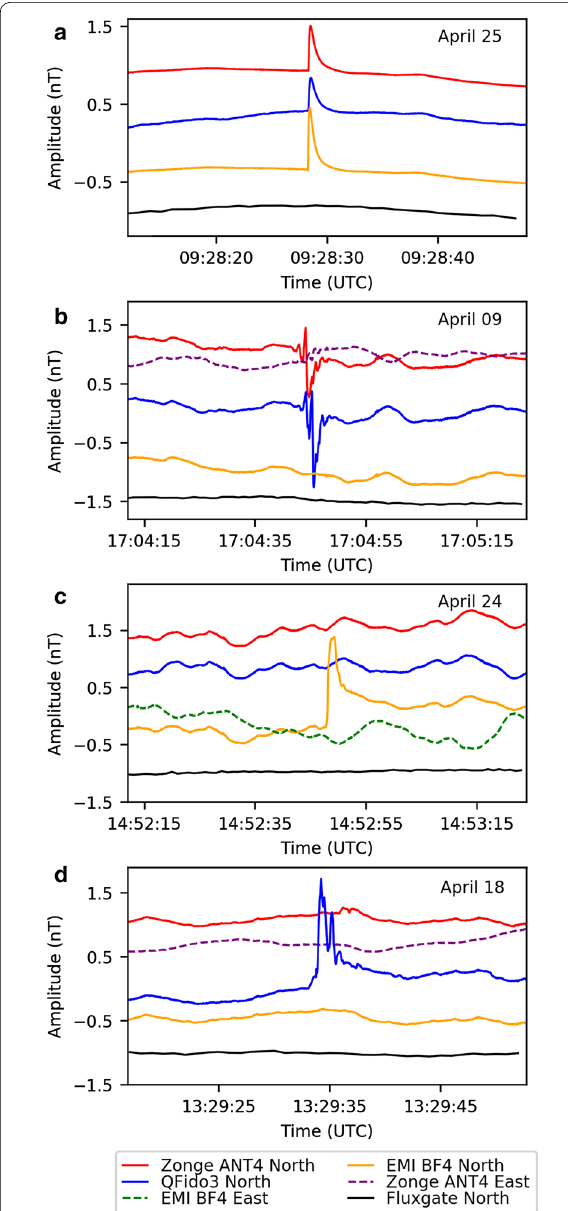
Fig. 10 Comparison of individual pulses as recorded on different systems, plotted as in Fig. 9b, but for shorter time periods (pulses are 1–10 s in duration). a Single-side pulse recorded on all mag- netometers at JRSC (Zonge ANT4, QFido3, EMI BF4) but not in Fresno, ~ 225 km distant. b Two-sided pulse recorded on all QuakeFinder sensors (Zonge ANT4, QFido3) but not on USGS-Stanford coils, ~ 50 m distant. c Pulse recorded only on USGS-Stanford north coil, but not on east coil ~ 5 m distant, nor on QuakeFinder sensors. d Signal seen on QuakeFinder QFido3 sensor, but not on Zonge ANT4 coil ~ 5 m distant, nor on USGS-Stanford EMI magnetometers. Traces from different sensors are all plotted at the same scale, but shown offset vertically for easier comparison. Where two components of the same instrument are shown (Zonge ANT4 N and E in b and d ; EMI BF4 N and E in c ) they are overlain without offset